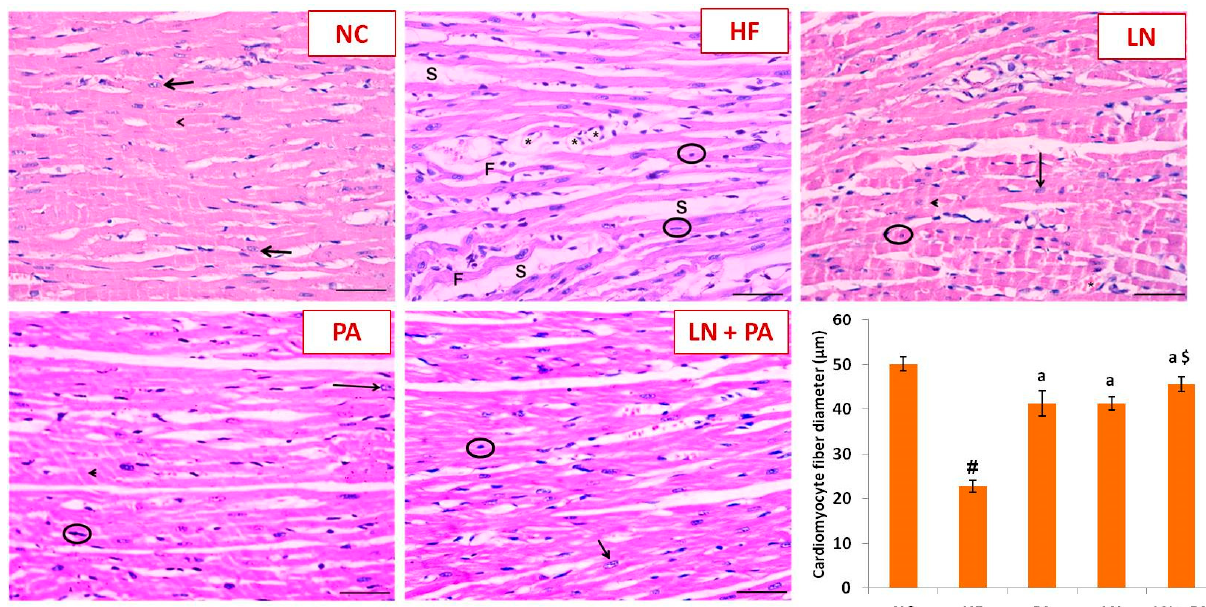
Figure 2. Photomicrographs of sections in the left ventricular myocardium from different experimental groups stained with H&E. HF was induced with doxorubicin (3.5 mg/kg, i.p., twice weekly for 3 weeks) and rats were treated with PA (10 mg/kg), LN (10 mg/kg) and their combination (PA + LN) orally and daily for 4 weeks. Normal control rat (NC) showing cardiomyocytes with acidophilic cytoplasm and striations with central bright nuclei (arrow). The intercalated disc was also seen (arrowhead). The left ventricular myocardium from rats in the HF group showed cardiomyocytes with darkly stained pyknotic nuclei (circle). Cardiomyocyte fibers (F) appear twisted and asymmetrical with loss of the striated appearance of the cardiac fibers. Wide interstitial spaces (S) were noticed among cardiac muscle fibers. Fat cell infiltration was seen between muscle fibers (*). Separated distorted muscle fibers were seen in the interstitium. Left ventricle from rats treated with LN, PA or LN + PA showed almost the same histological structure. Some cardiomyocytes presented with bright vesicular nuclei (arrow), and others had darkly stained nuclei (circle). Intercalated discs were present between the fibers, and cytoplasmic striations were noticed (arrowhead), scale bar 20 µ m. The diameter of cardiomyocyte fibers was analyzed in 18 different fields from each group, and data were presented as mean ± SD. # significant from NC at p < 0.001, a significant from HF at p < 0.001 and $ significant from both LN and PA at p < 0.001.